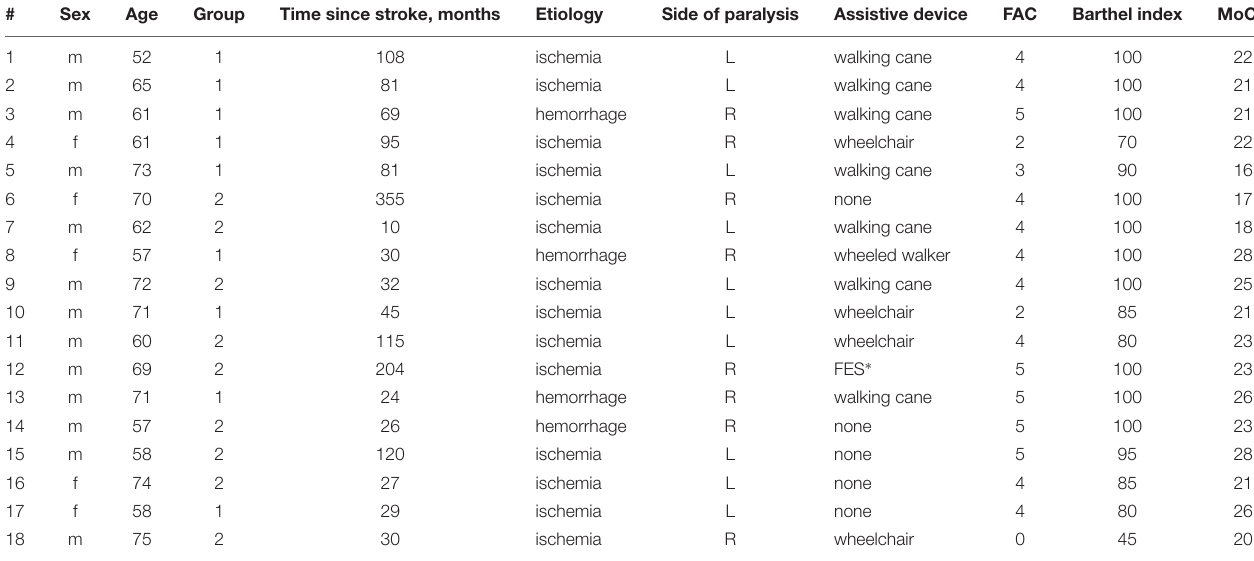
TABLE 1 | Demographic and clinical characteristics of the patients.